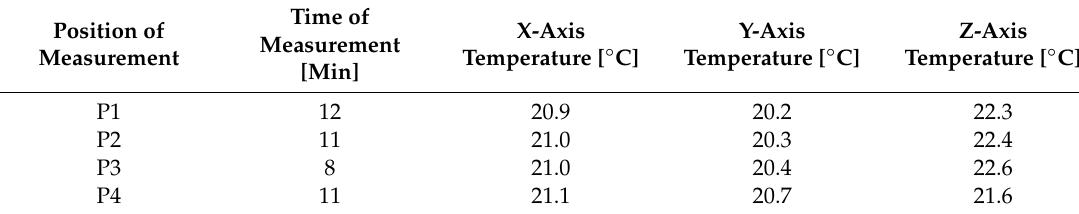
Table 6. Conditions of verification measurement.